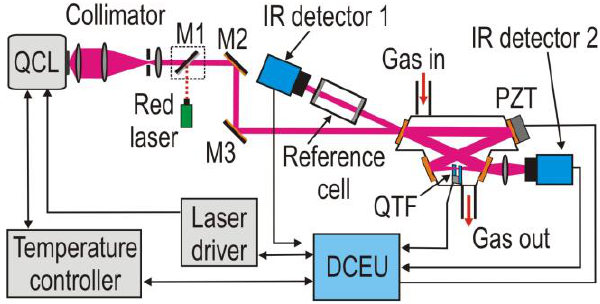
Figure 1. Schematic of an I-QEPAS nitric oxide sensor platform.